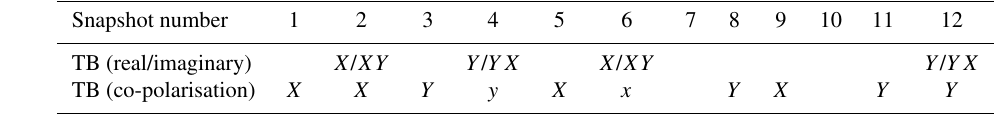
Table 2. Acquisition sequences of SMOS in full polarisation mode (capital letters are used for pure acquisition).